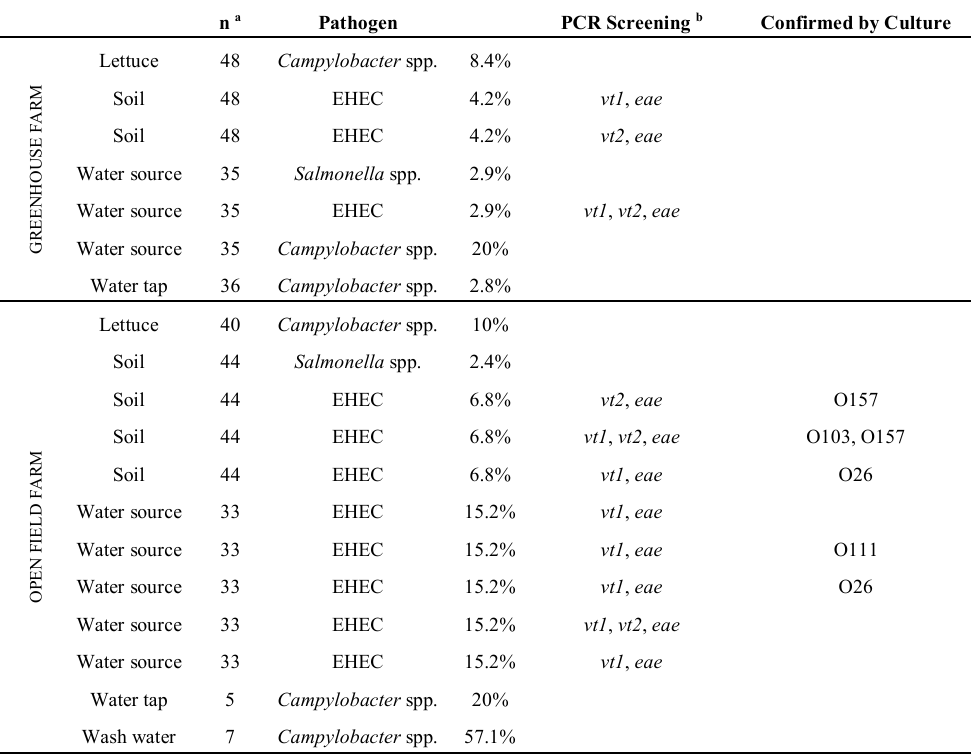
Table 3. Pathogen prevalence in lettuce, soil, and seedling samples (presence /25 g) and in water samples (presence per liter) taken in greenhouses and open field farms. n a Pathogen PCR Screening